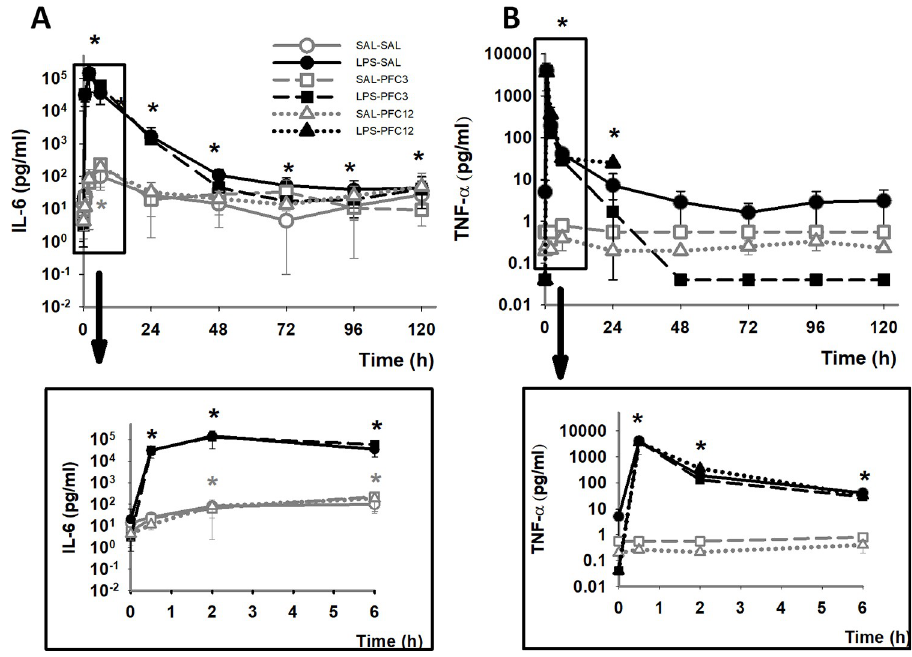
time course. Lower panels show early time points on an expanded scale. Open or closed symbols depict initial infusion conditions with open for saline and closed for LPS. Graphs of initial infusions with saline are in grey. Symbol type depicts second infusion with squares, circles and triangles for saline, PFC3 and PFC12, respectively. Error bars depict SEM. Data that are significantly different, p < 0.05, are shown compared to: baseline, by � . Both treatment group